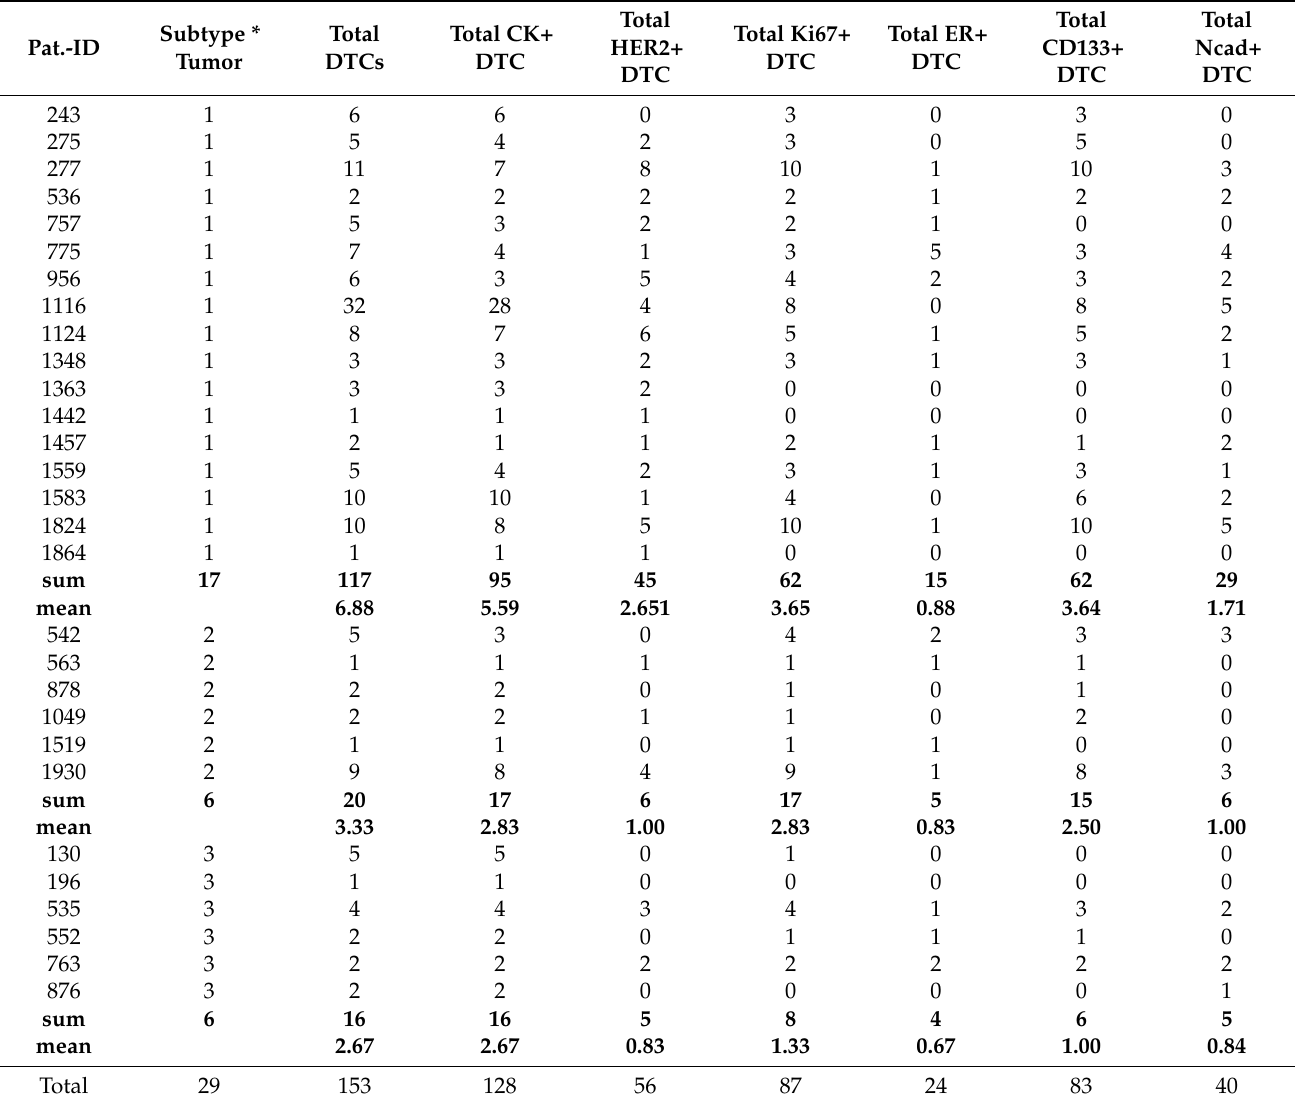
Table 3. Quantification of DTCs according to intrinsic